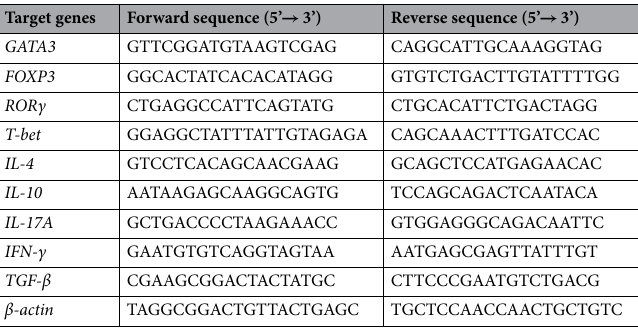
Table 7. Primer sequences were used in the